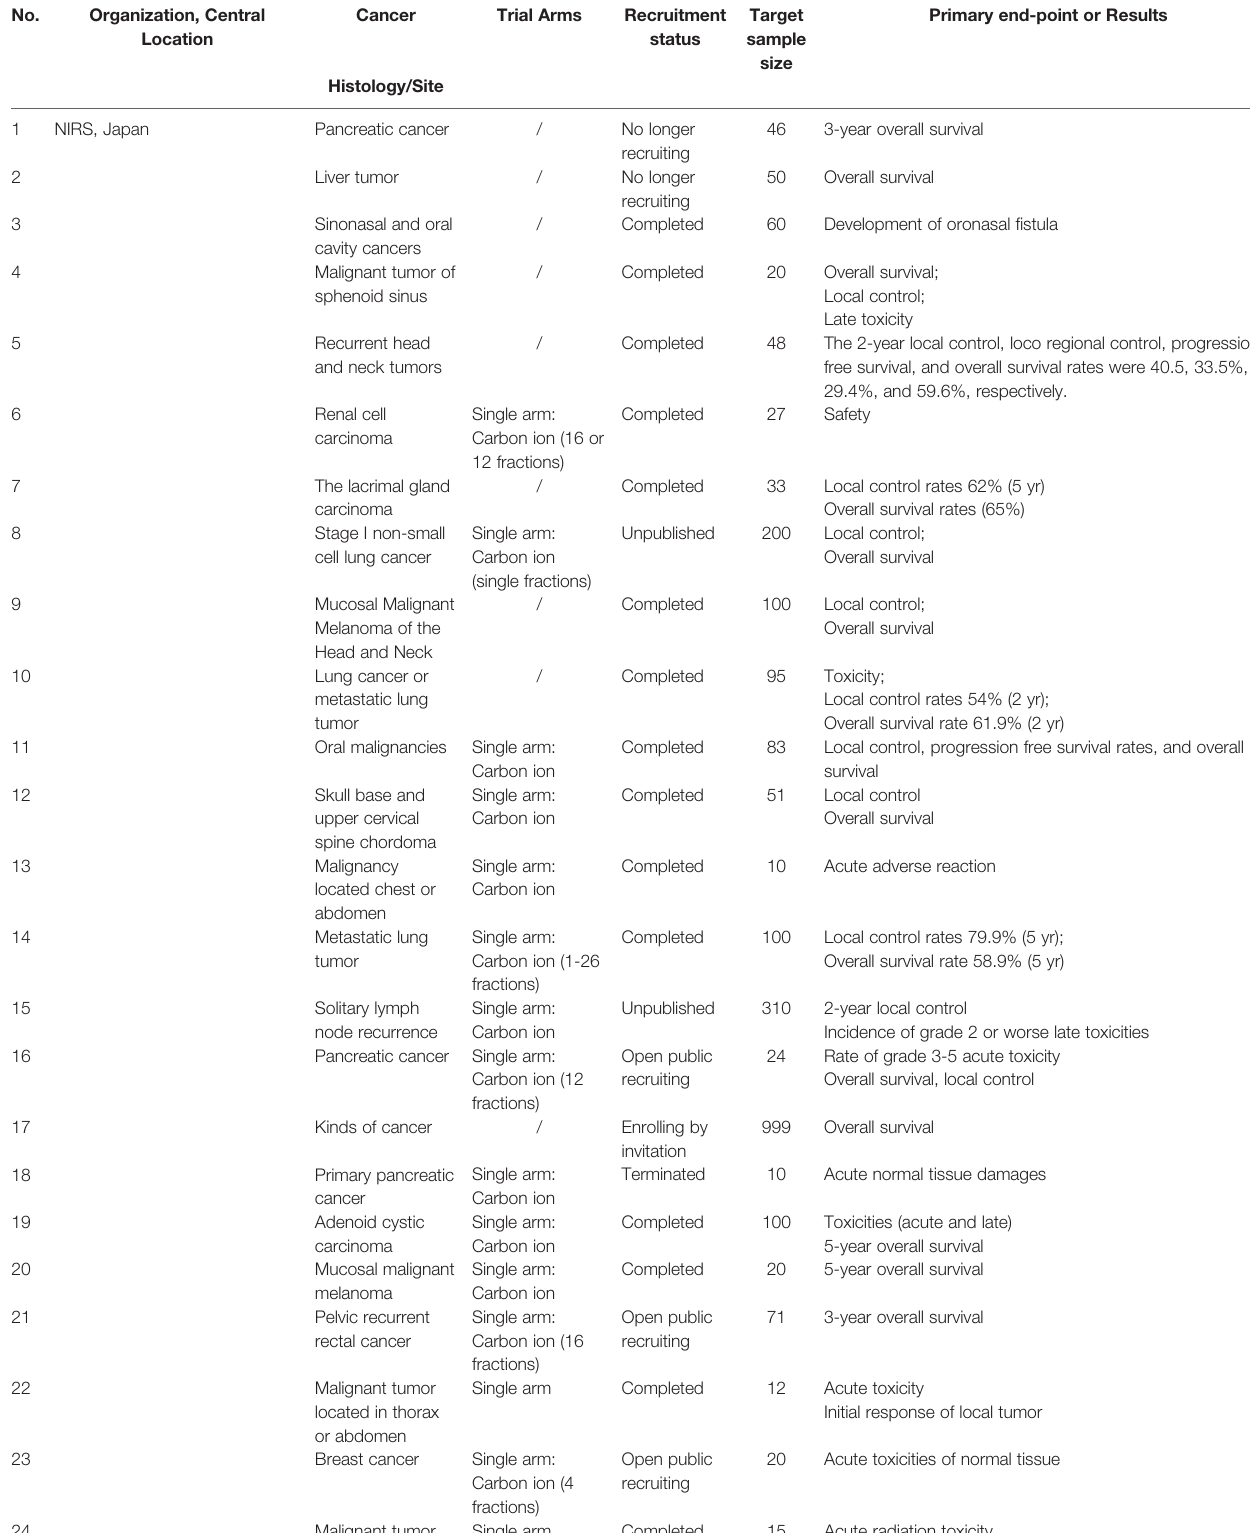
TABLE 3 | A list of selected open and/or recruiting clinical trials using CIRT alone or in combination with other treatment modalities.